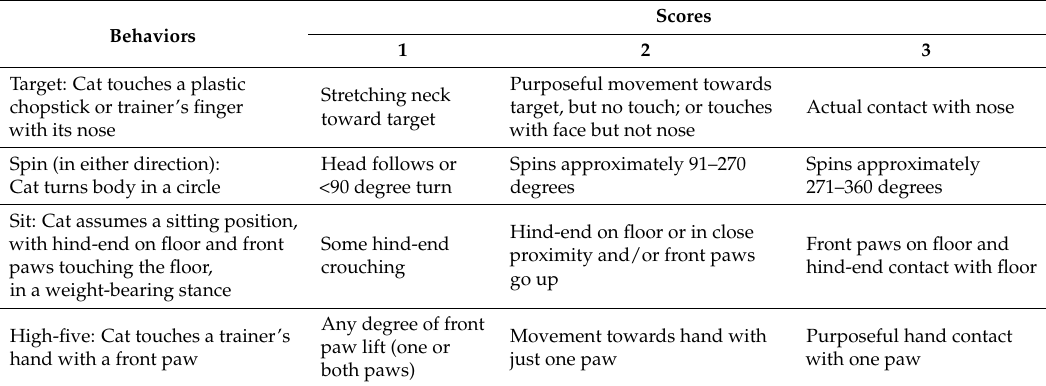
Table 1. Behavior scoring parameters for cats’ behavior when cued. In all cases, if no semblance of the cued behavior was offered, the score was 0.